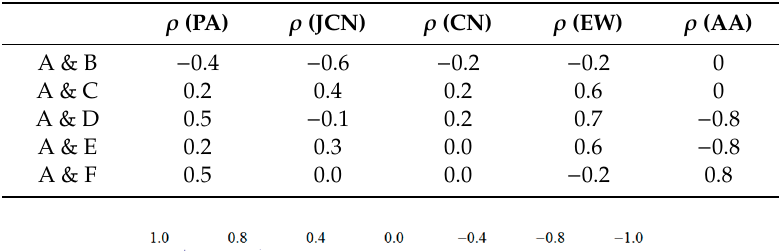
Table 4. Pearson’s coefficient for neighbor-based metrics.